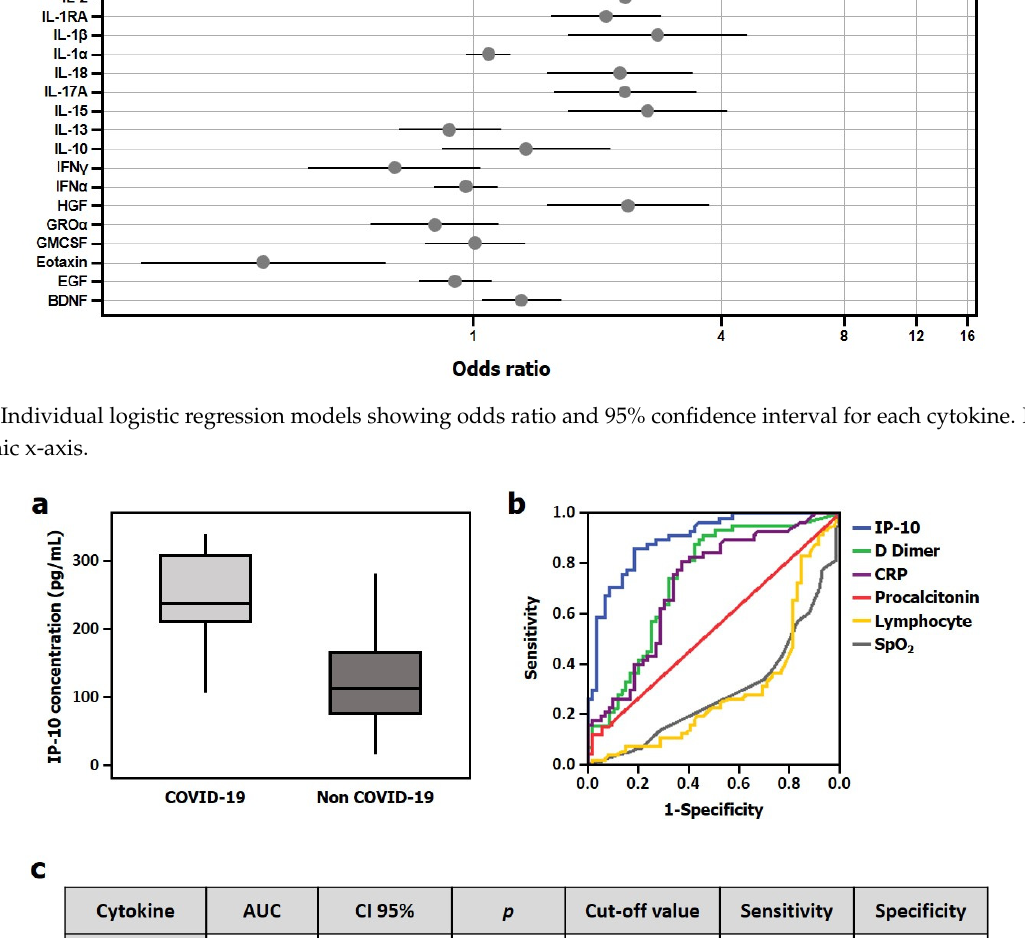
Table 2. Area under the receiver operating characteristic curve (AUROC) analysis of the 18 signifi- cant cytokines. The bold is to indicate statistical significance.